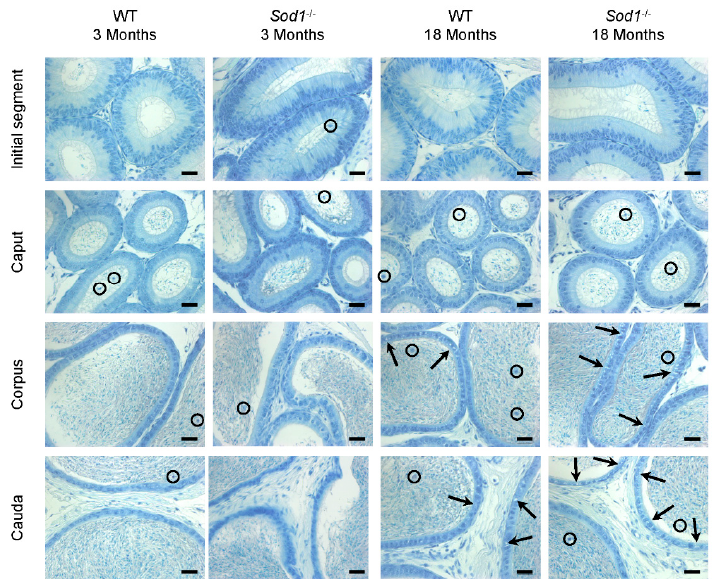
Figure 1. The histology of the epididymis is affected by aging in wild-type mice and even more so in Sod1 − / − mice. Representative pictures of epididymal sections (initial segment, caput, corpus, and cauda epididymides) stained with toluidine blue from 3-month-old and 18-month-old wild-type and Sod1 − / − mice. An increase in luminal round cells (circles) and in the number and size of clear vesicles (arrows) were observed in the epididymal epithelium of the corpus and cauda epididymides (n = 3). Scale bar: 40 µm.